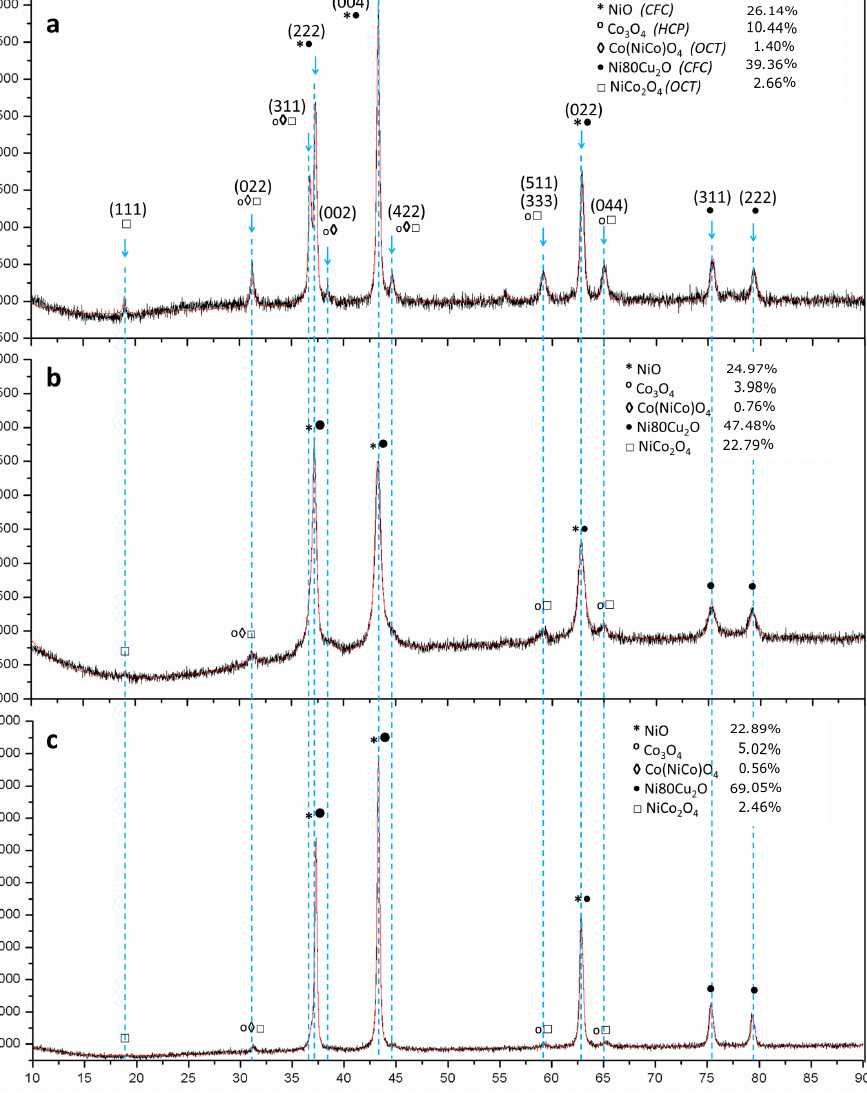
Figure 3. XRD of the co-formed oxides thermally decomposed at 500 ◦ C: ( a ) 24Cu–oxide; ( b ) 12Cu– oxide; ( c )